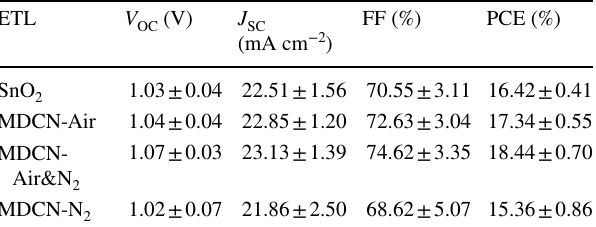
Table 1 Device performance of PSCs with SnO 2 , MDCN‑Air, MDCN‑Air&N 2 , and MDCN‑N 2 ETLs (30 samples for each type of